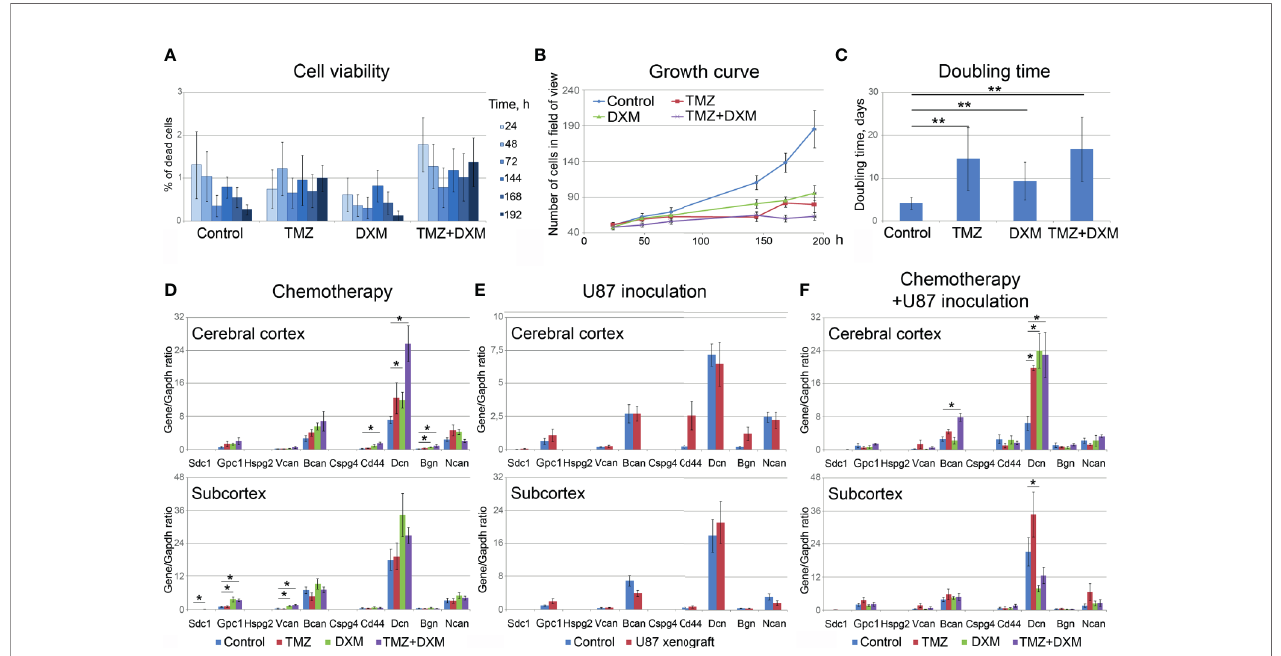
FIGURE 4 | Effects of TMZ and/or DXM on normal glial cells and proteoglycans expression in brain tissue. (A) Viability of primary glial cells during the treatments (as a percentage of dead cells in the culture). (B) Growth curves of the control and TMZ/DXM-treated cells. (C) Doubling time for the control and treated cells. (D, E) PG core proteins mRNA levels in cortex and subcortex before and after treatments with TMZ and/or DXM (D) or U87 cells inoculation (E) or combination of TMZ/DXM treatments and inoculation of U87 cells (F) . Real-time RT – PCR analysis, intensity of the ampli fi ed DNA fragments normalized to that of Gapdh . Bars represent the mean ± SD from triplicate experiments (OriginPro 8.5). ANOVA + Fisher ’ s LSD test, *p < 0.05, **p < 0.01. TMZ, temozolomide; DXM,